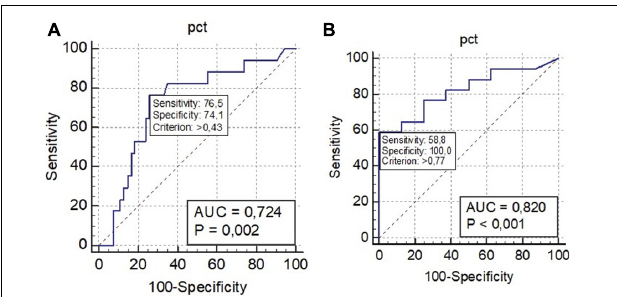
FIGURE 3 | ROC curve: procalcitonin (PCT) Group 1 vs. Group 2 as unique biomarker discriminating Group 1 from Group 2 (A) and PCT Group 1 vs. Group 3 as unique biomarker discriminating Group 1 from Group 2 (B) . AUC, area under the curve; q-SOFA, quick Sequential Organ Failure Assessment; SIRS, systemic inflammatory response syndrome; SOFA, sequential organ failure